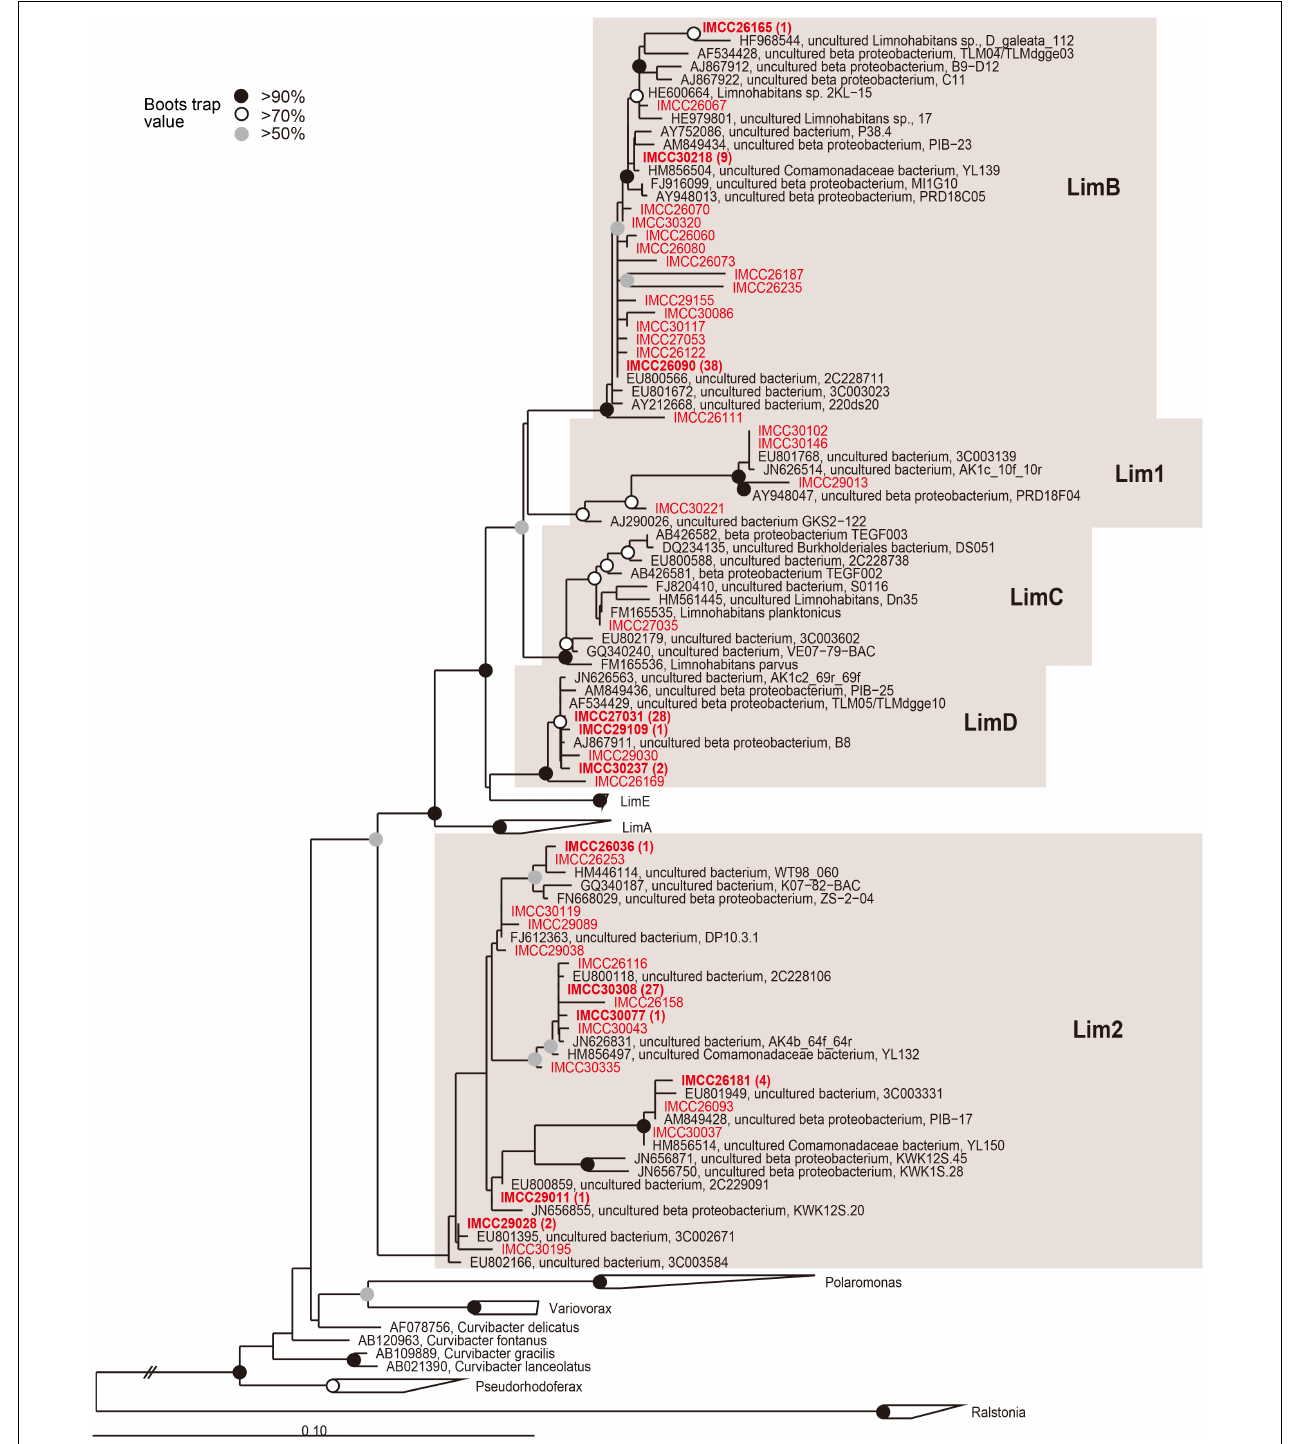
FIGURE 2 | Maximum-likelihood phylogenetic tree based on 16S rRNA gene sequences showing the positions of the HTC isolates within the Limnohabitans lineage. The HTC isolates are prefixed with the “IMCC” abbreviation (Inha Microbe Culture Collection) and marked in red. HTC isolates sharing identical 16S rRNA gene sequences are indicated by one representative strain and the numbers of the other isolates sharing the same sequences are indicated in parentheses. The Lim1 and Lim2 linages were named in this study. Bootstrap supporting values are shown at the nodes as solid circles ( > 90%), empty circles ( > 70%), and gray circles ( > 50%).